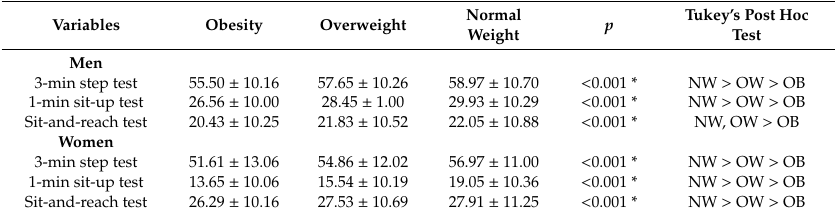
Table 3. Health-related physical fitness and anthropometric characteristics measurements according to general obesity status in Taiwanese adults.